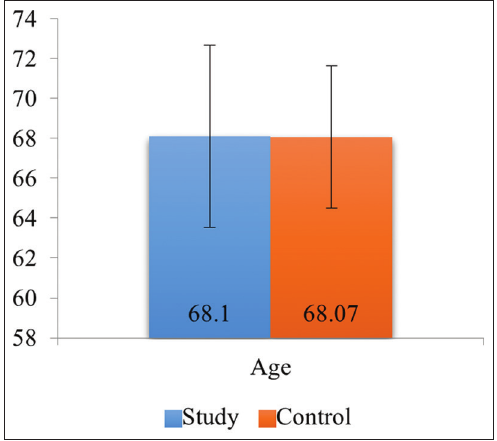
FIGURE 1. The average age of women in the study and in the control group.